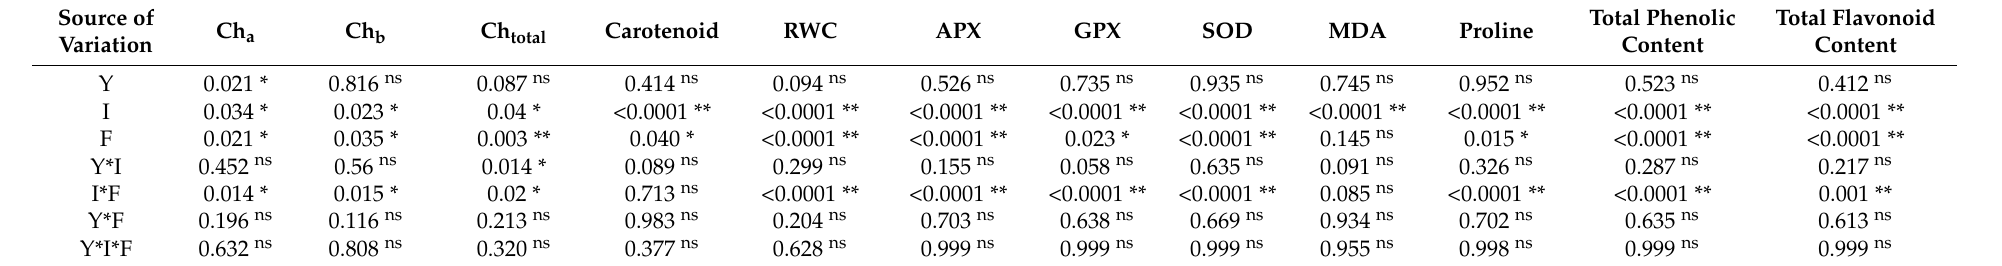
Table 2. The ANOVA ( p -value) results of chlorophylls, carotenoids content, relative water content, antioxidant enzymes activities, proline, malondialdehyde, total phenolic, and flavonoid content of peppermint affected by experimental